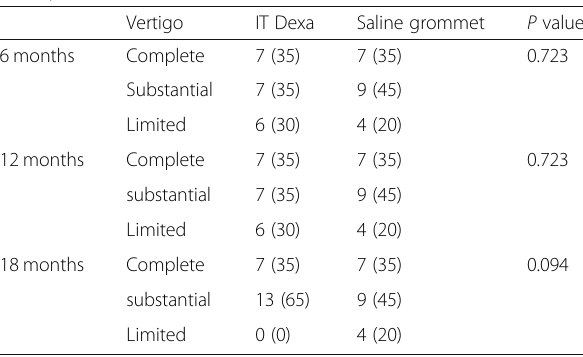
Table 7 Comparing the groups IT Dexa group and saline through the grommet group regarding control of vertigo by chi-square test